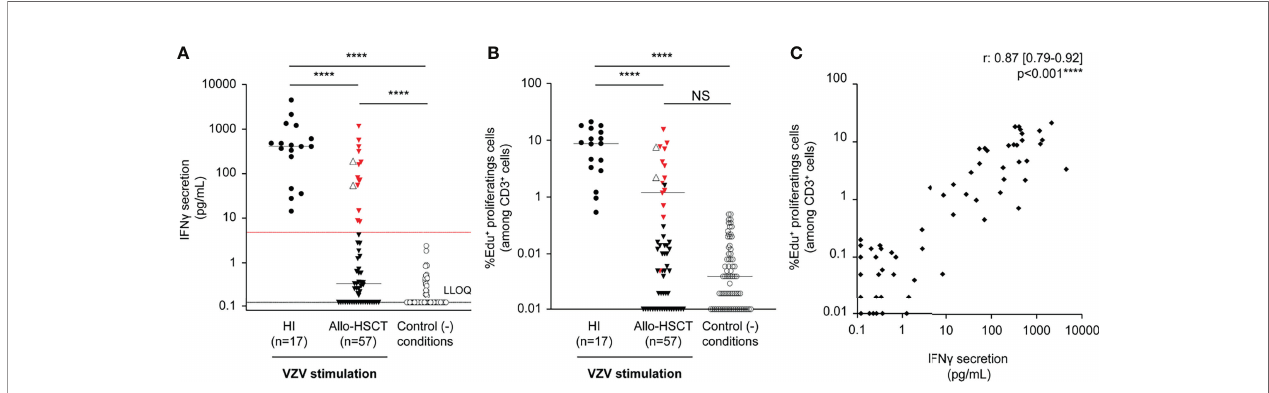
FIGURE 1 | VZV-speci fi c cell-mediated immunity according to immunoassays on peripheral blood mononuclear cells. Peripheral blood mononuclear cells isolated (1 × 10 5 cells) from healthy individuals (HI, n = 17) and allogeneic hematopoietic stem cell transplant recipients (allo-HSCT, n = 57) were stimulated by VZV antigen (inactivated supernatants from VZV-infected MRC-5 cells, 20 µg/ml) or supernatants from VZV-uninfected MRC-5 cells (control condition) and incubated for 7 days in duplicate. (A) IFN- g release (pg/ml) in the supernatants was quanti fi ed using the ELLA nano fl uidic system. Bars represent median values, black dotted line represents the lower limit of quanti fi cation (LLOQ = 0.17 pg/ml), and red dotted line represents the arbitrarily de fi ned threshold of positivity of the assay, i.e., 4.83 pg/ml, corresponding to twice the maximum value observed in the control condition. All values below LLOQ have been set at 0.12 pg/ml corresponding to LLOQ/ √ 2. (B) In respective wells, T-cell proliferation is expressed as the percentage of EdU + proliferating cells (among CD3 + cells) measured by fl ow cytometry after EdU + incorporation and completion of the Click-it ® . Groups were compared using Kruskal – Wallis test; **** P <.0001, NS: not signi fi cant. Red triangles represent recipients de fi ned as VZV-responders, i.e., having recovered a VZV-speci fi c cellular-mediated immunity according to the IFN- g release assay. Clear triangles represent recipients who developed herpes zoster- related manifestations. (C) Correlation analysis between T-cell proliferation and IFN- g release results obtained from the same well was performed using Spearman rank- correlation test; the P-values and the correlation coef fi cient are indicated. Data were missing for three VZV-stimulated allo-HSCT